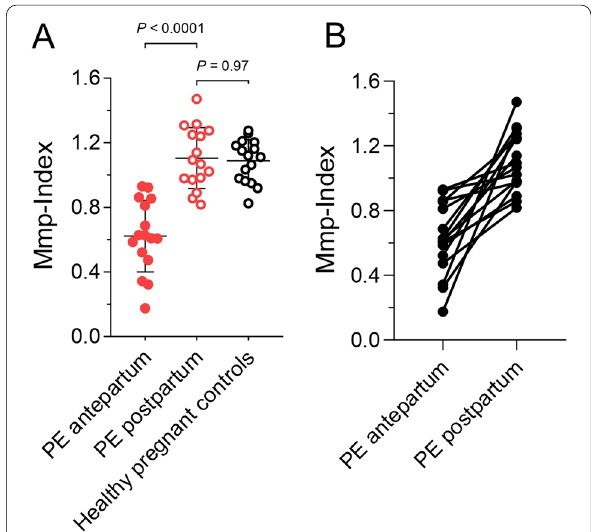
Fig. 3 Platelet mitochondrial membrane depolarization during PE normalizes to baseline levels after delivery. A Platelet Mmp-Index of patients with PE (PE antepartum) increases after delivery (PE postpartum) and normalizes to baseline levels of normal pregnant controls (p 0.97). B Illustration of the individual development = of platelet Mmp-Index for each PE patient pre- (antepartum)